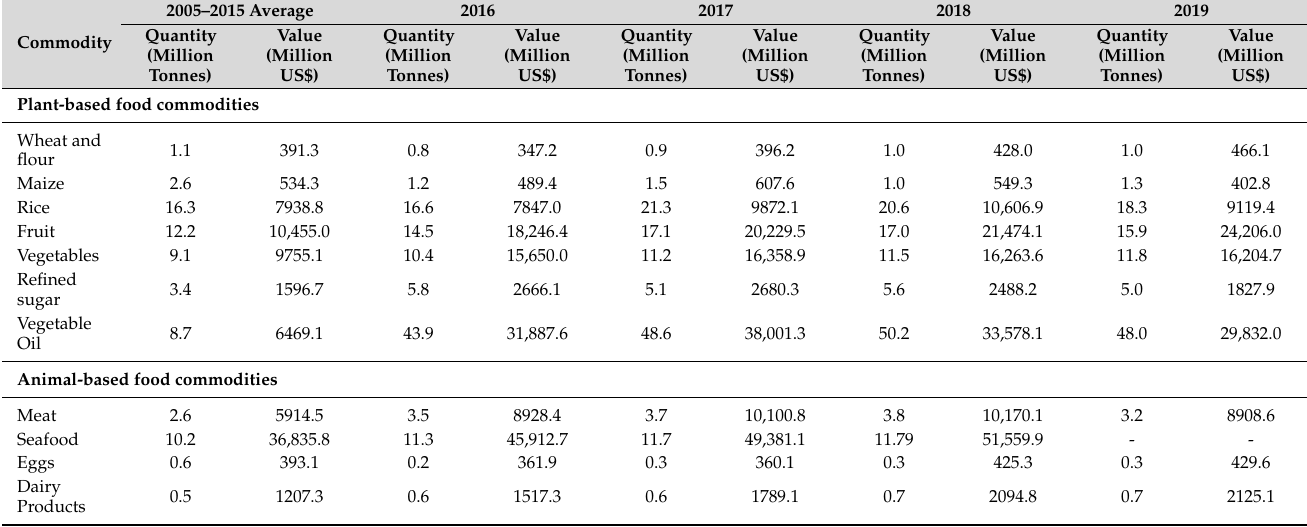
Table 3. Major food commodity exports in East and Southeast Asia.